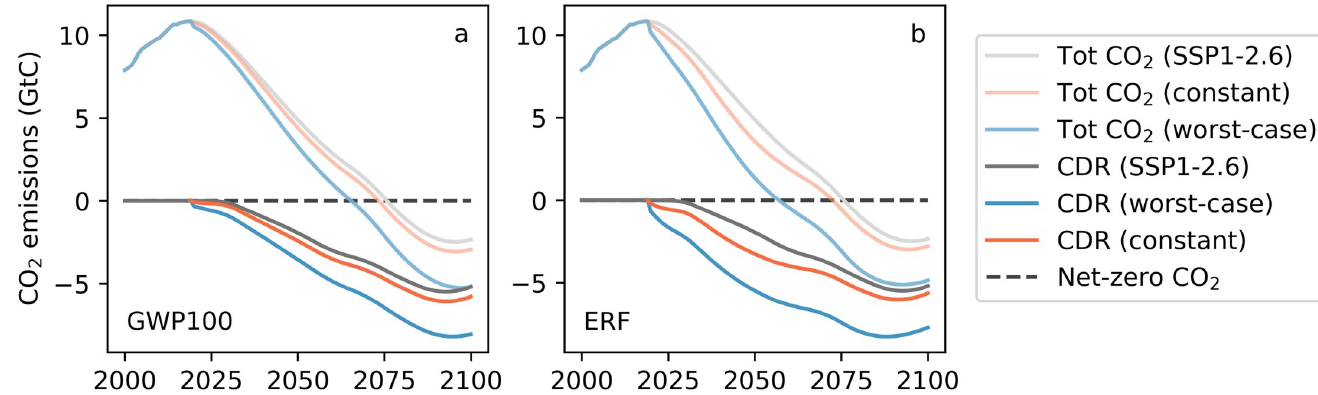
Fig 2. Total CO 2 emissions and CDR rates under the two offsetting approaches. CO 2 emissions under the reference scenario (SSP1-2.6) and under a policy scenario in which alternative agricultural emission pathways (constant in orange and worst-case in blue) are offset via CDR. Light coloured lines correspond to the total CO 2 emissions (including CDR) while darker coloured lines correspond to the total CDR rates. We show the results for two different offsetting approaches: (a) “GWP100” based on the GWP100 metric and (b) “ERF” based on the explicit computation of CDR rates required to achieve the RCP2.6 methane ERF.